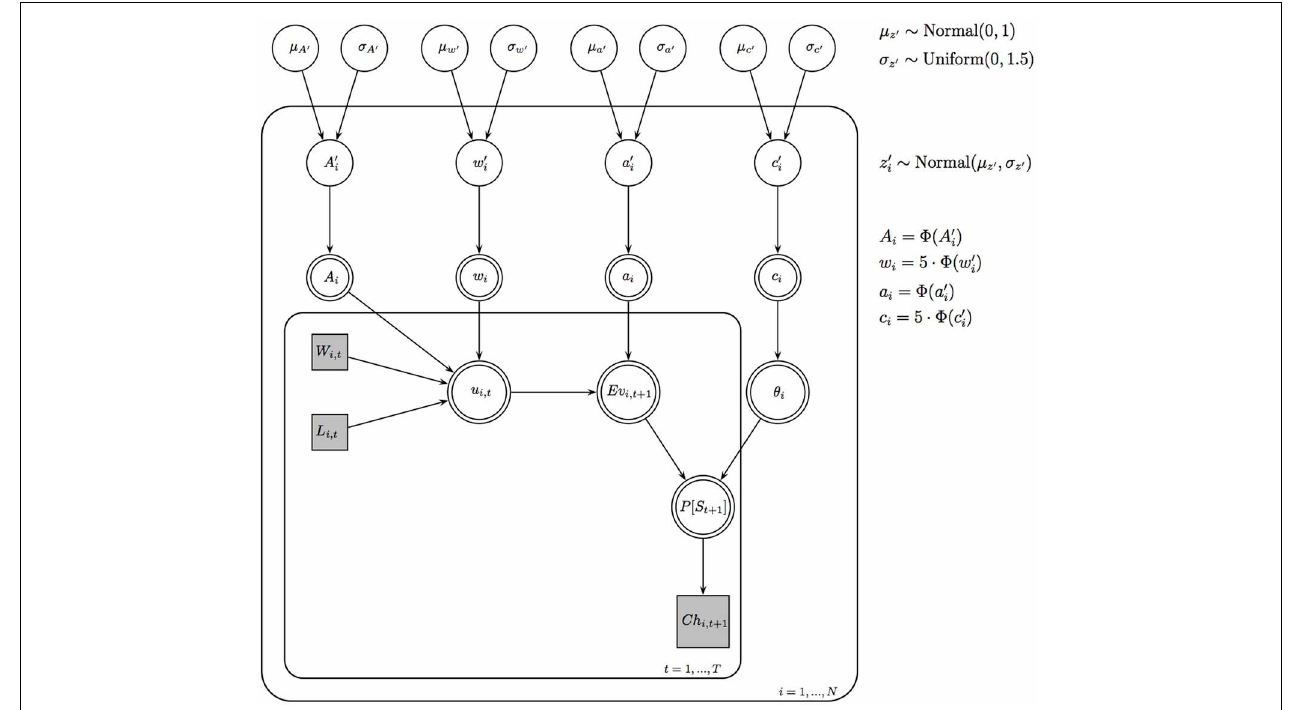
FIGURE 8 | Bayesian graphical PVL-Delta model for a hierarchical analysis. (cid:2)() is the cumulative standard normal distribution function.